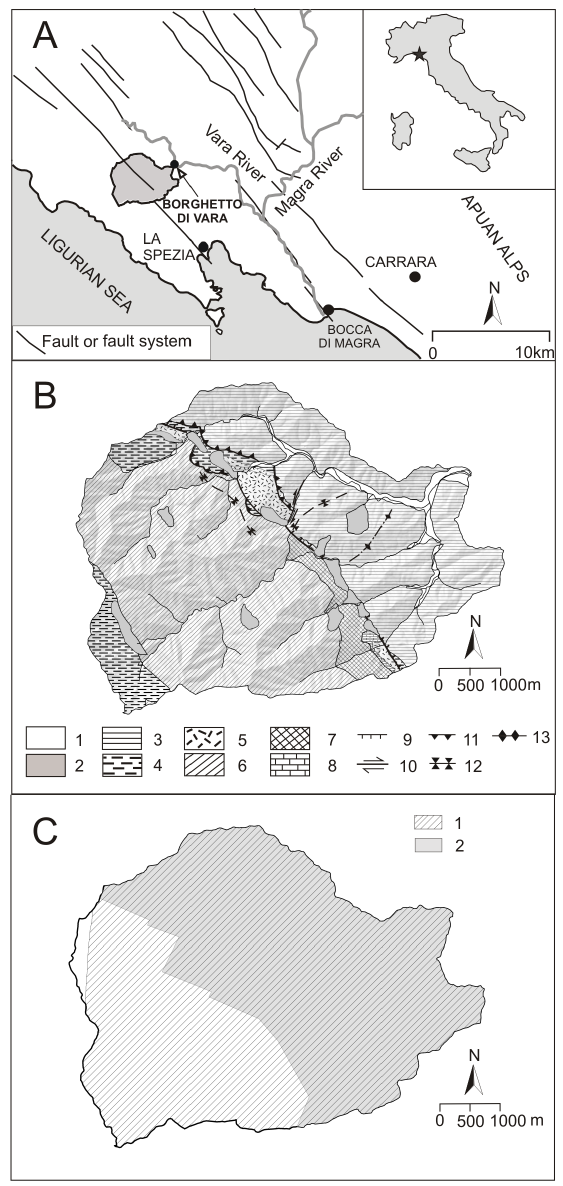
Figure 1. The Pogliaschina catchment. (A) Location map. Dark grey area shows location of the Pogliaschina catchment. (B) Geolo- gical map: (1) fluvial deposit, (2) landslide deposit, (3) Monte Got- tero Flysch, (4) clay-rich rocks, (5) igneous and metamorphic rocks, (6) Macigno Flysch, (7) Scaglia Toscana, (8) Maiolica, (9) nor- mal fault, (10) strike-slip fault, (11) thrust fault, (12) anticline axis, (13) syncline axis. (C) Coverage of satellite and aerial images.